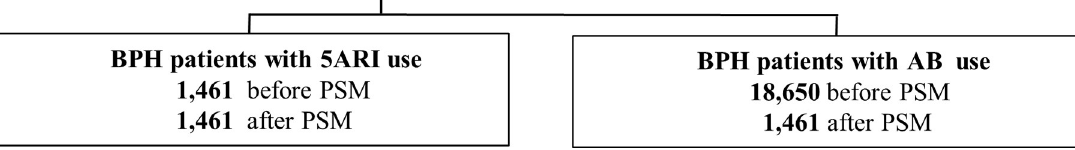
Fig 1. The flow chart of study population (BPH patients with prescription 5ARI or AB). Abbreviations: BPH, benign prostatic hyperplasia; 5ARI, 5alpha reductase inhibitor; AB, alpha blocker; PSM, propensity score matching.